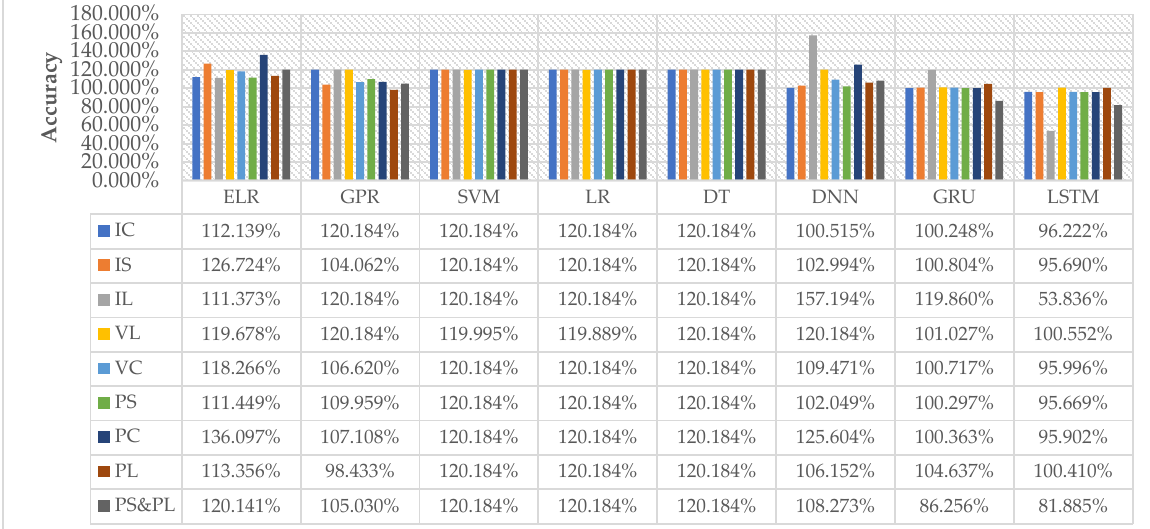
Figure 11. Average accuracy of the estimated capacitance with fast Fourier transform (FFT) analysis and low-pass filter 2.